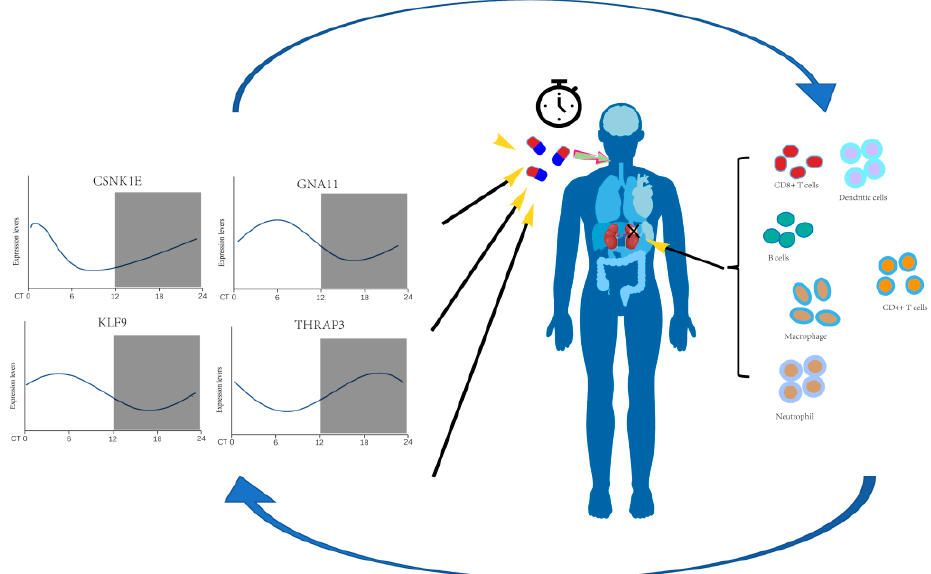
Figure 10. A schematic diagram of the effects and prognostic values of circadian genes CSNK1E/GNA11/KLF9/THRAP3 in kidney renal clear cell carcinoma. Supplementary Materials: The following supporting information can be downloaded at: https: www.mdpi.com/xxx/s1, Figure S1: GO and KEGG analyses of 1368 circadian genes. (A) GO analy- sis; (B) KEGG analysis, Figure S2: GO enrichment analysis of DERGs. (A) Cell component enrich- ment analysis; (B) molecular function enrichment analysis, Figure S3: The survival curves of DERGs by the KM plotter online tool. (A) CSNK1E; (B) GNA11; (C)KLF9; and (D) THRAP3, Figure S4: The correlation between the expression levels of other DERGs and the survival rate of KIRC patients, Figure S5: The expression levels of DERGs in KIRC samples from GEO datasets. (A) CSNK1E; (B) GNA11; (C) KLF9; and (D) THRAP3, Figure S6: Representative images of CSNK1E/ GNA11/ THRAP3 immunohistochemistry in kidney and renal cancer tissues by the human protein atlas online tool (no relevant data found for KLF9 immunohistochemistry), Figure S7: Correlation analysis between DERGs expression and clinical variables. (A) CSNK1E; (B) GNA11; (C) KLF9; and (D) THRAP3, Figure S8: Correlation heatmap depicting correlations between infiltrating im- mune cells in KIRC, Figure S9: Hazard ratios of 101 differentially expressed immune genes associ- ated with survival, Figure S10: The correlation analysis between PD-L1(CD274) expression and CSNK1E/GNA11/KLF9/THRAP3 expression. (A) The PD-L1(CD274) mRNA level in 539 KIRC samples and 72 normal samples; (B) The correlation between PD-L1(CD274) expression and CSNK1E/GNA11/KLF9/THRAP3 expression with TIMER online tool, Table S1: The 553 DERGs between KIRC samples and normal tissue samples, Table S2: GO analyses, Table S3: The KEGG pathway enrichment analysis, Table S4: The expression levels of DERGs in the normal and KIRC tissues, Table S5: The clinical data of KIRC patients.